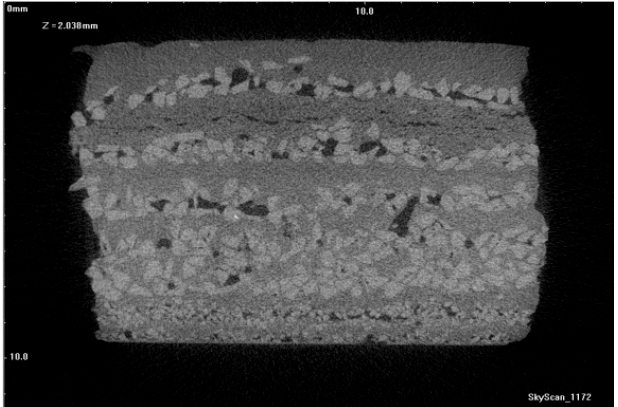
Figure 19. Example tomogram of SiC 1200 °C sample cross section.